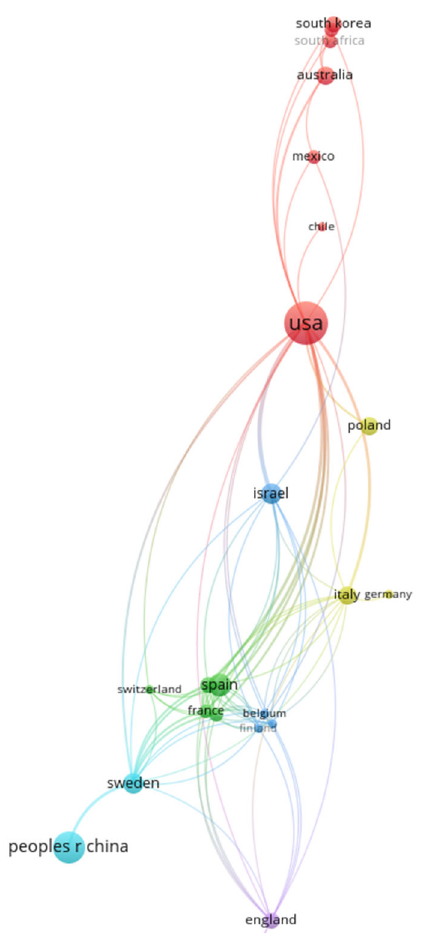
Figure 8. Country/region co ‐ authorship map for prenatal exposure to air pollution publication. The area of the map in Figure 8 depicting collaborating countries/regions was en ‐ larged for visibility purposes and is shown in Figure 9.